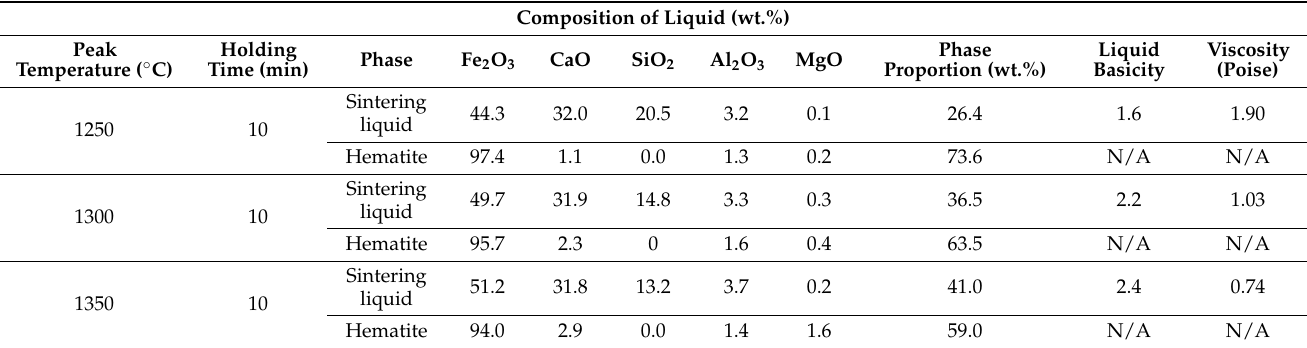
Table 3. Phases and phase compositions present in sinter ‘S2’ upon reheating at 1250 ◦ C, 1300 ◦ C, and 1350 ◦ C, followed by quenching and EPMA.